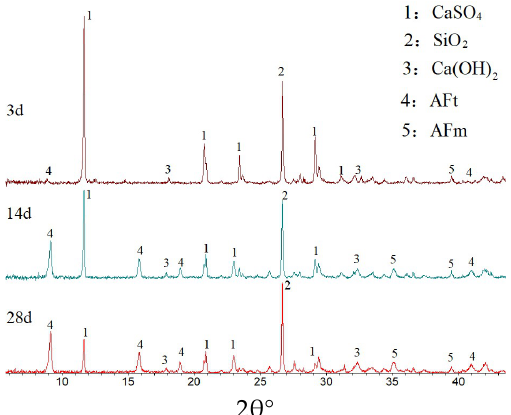
Figure 6. X-ray diffraction (XRD) diagrams of curing agents at different curing times.